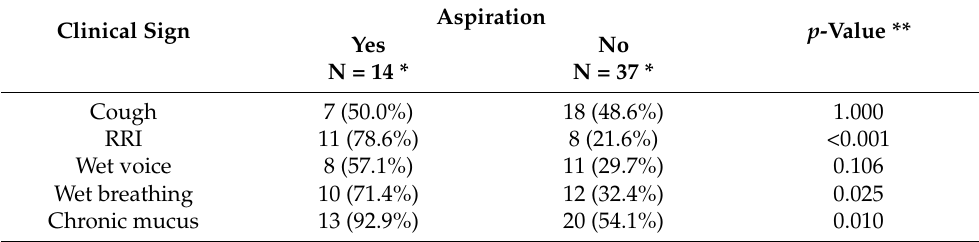
Table 3. Relationships between clinical signs and occurrence of aspiration in videofluoroscopic swallowing study.